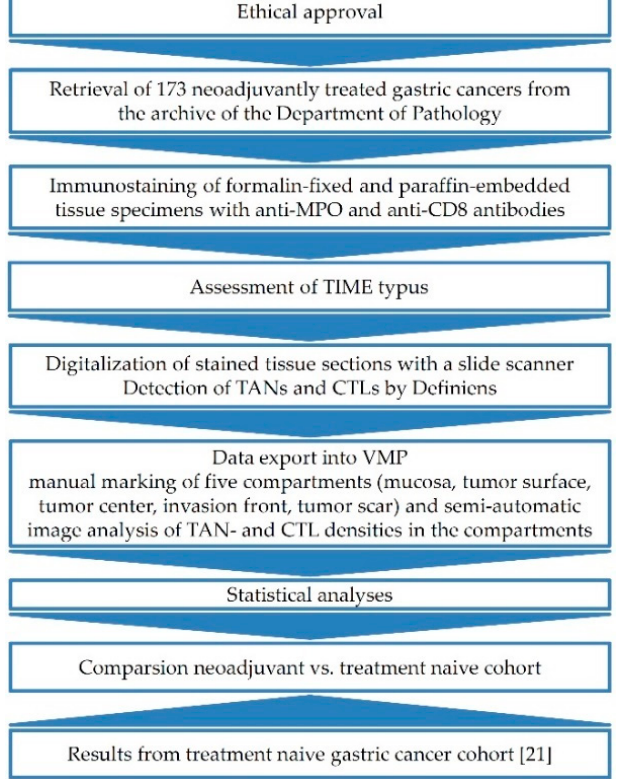
Figure 1. Schematic overview of the study methodology.